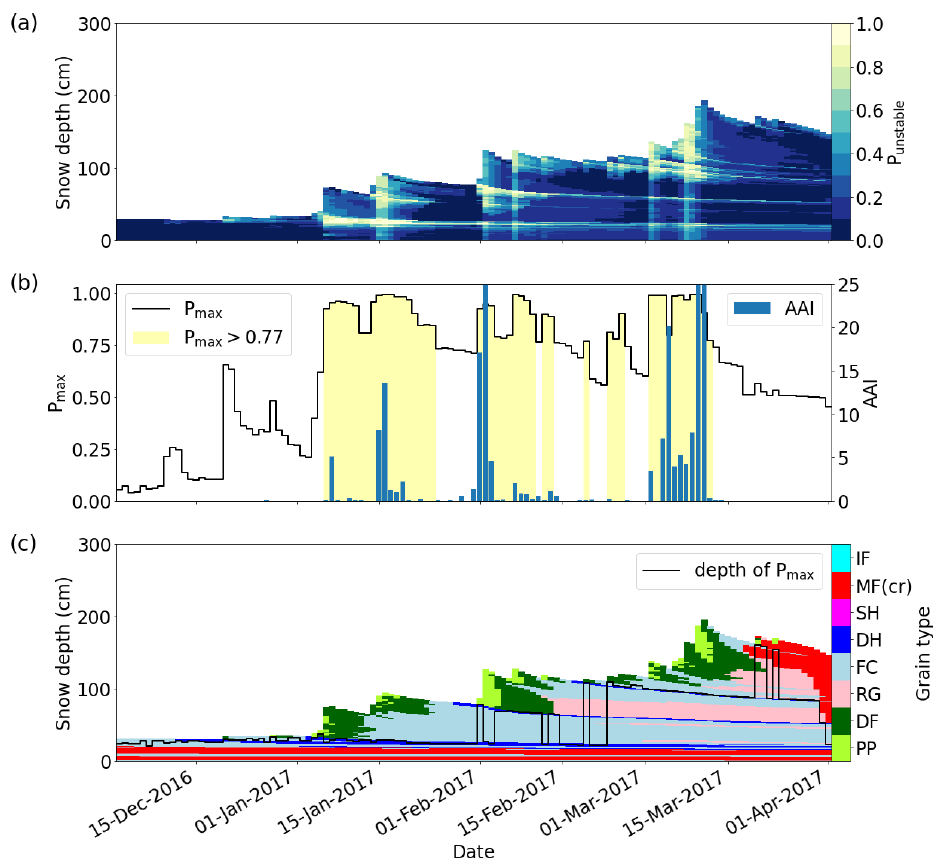
Figure 14. Evolution of (a) probability of instability P unstable (colors), (b) maximal values P max (black line) and avalanche activity index (AAI, blue bars), and (c) the depth of P max (black line) and grain types (colors) calculated for the simulated snow stratigraphy at the AWS Weissfluhjoch (WFJ, 2540ma . s . l . ) during the winter season 2016/17. Grain types were coded after Fierz et al. (2009) (see caption of Fig. 3). Yellow-shaded areas in (b) indicate days with P max exceeding the threshold T = 0 .